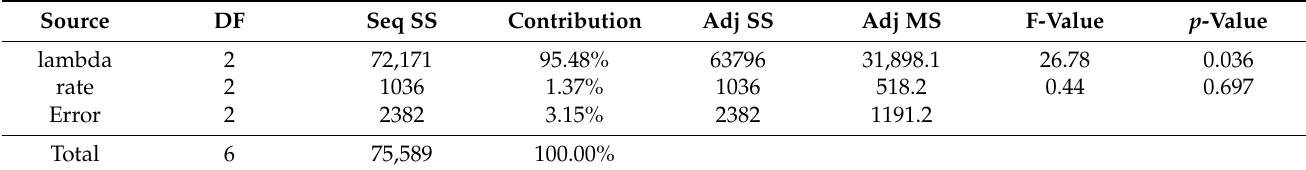
Table 13. ANOVA of AZ hardness with respect to the lambda and rate explanatory variables.